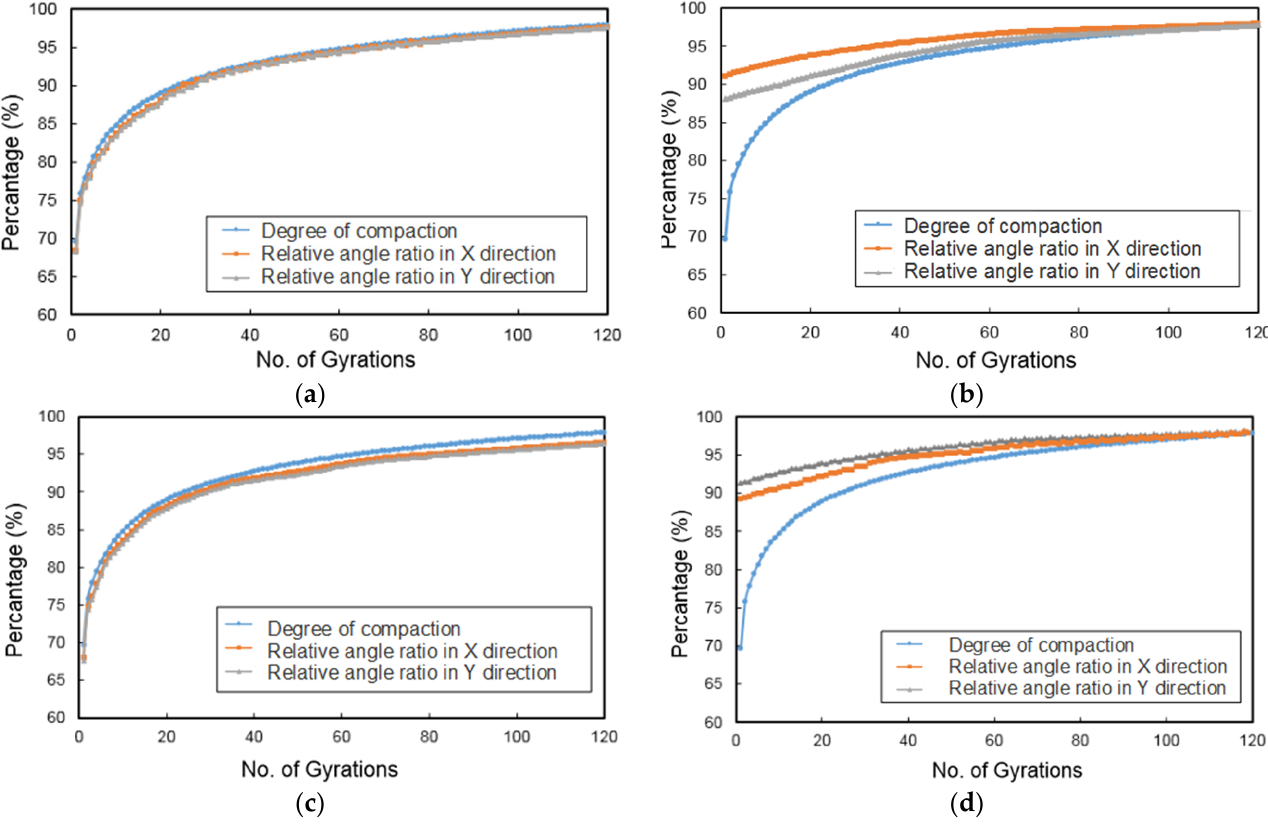
Figure 19. The relative rotation ratio and the degree of compaction at different positions of the specimen versus the number of gyrations: ( a ) upper center, ( b ) middle center, ( c ) lower center, and ( d ) center